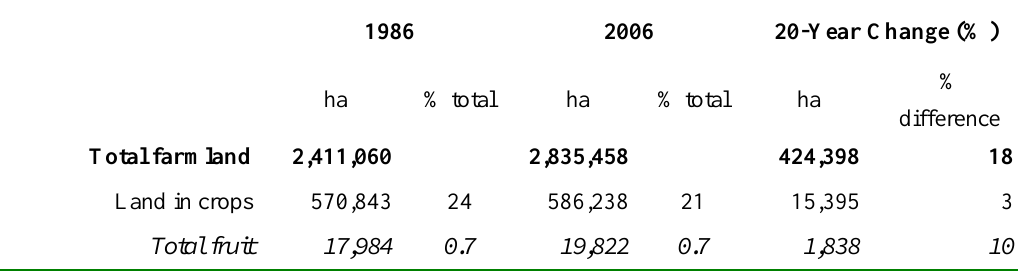
Table 1. Hectares of Farmland in BC Planted with Various Crops,